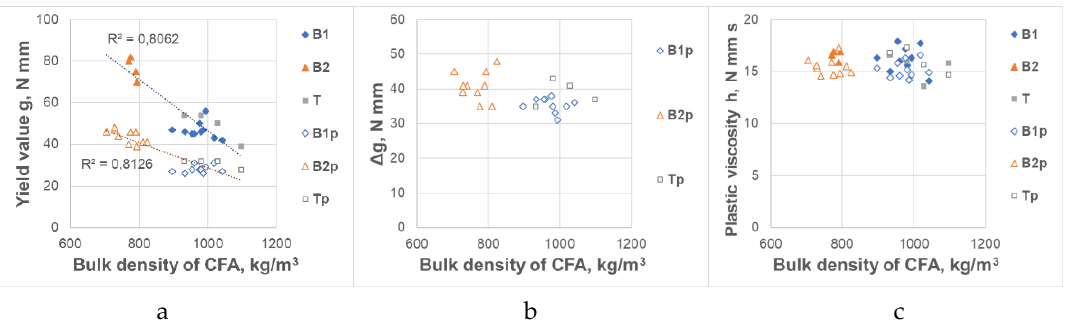
Figure 4. Influence of CFA bulk density on rheological properties of CFA mortars. ( a ) Yield value g; ( b ) Increase of the yield value g in time Δg, ( c ) Plastic viscosity h.